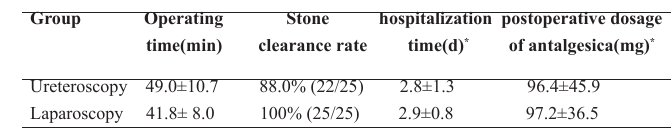
TABLE 2 - Operation indexes of patients between two groups